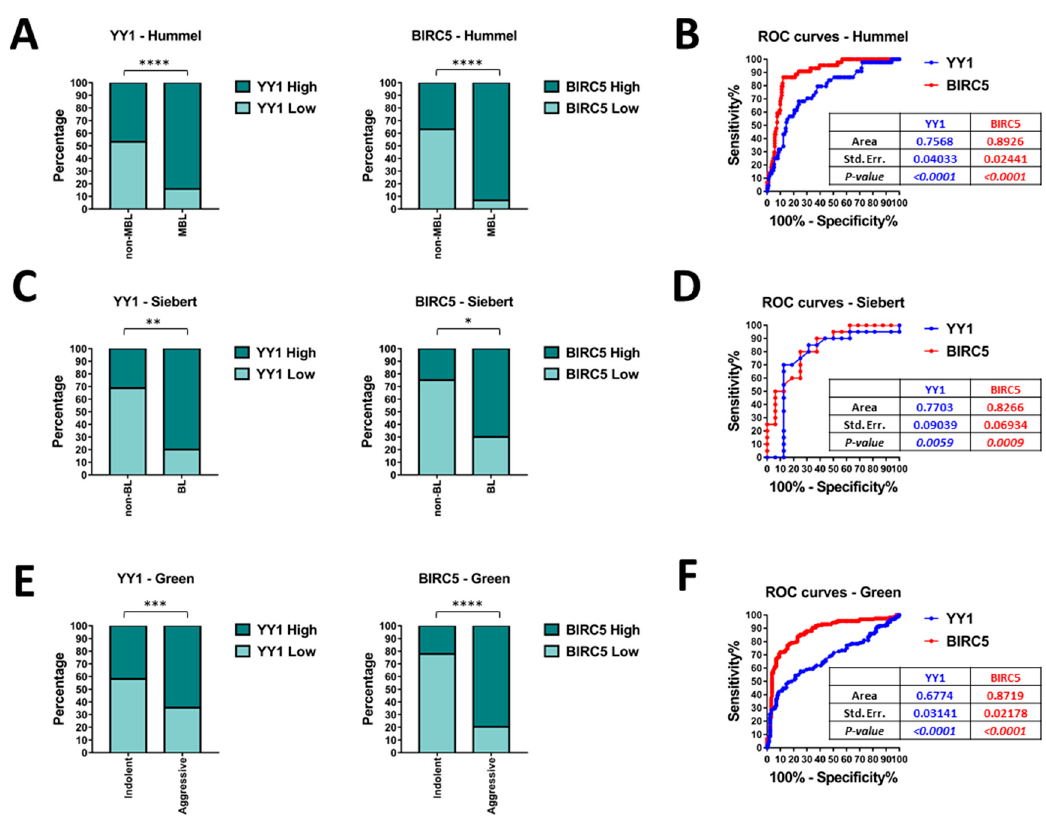
Figure 4. Fisher’s exact test and receiver operating characteristics (ROC) analysis of relevant B-NHL GEO datasets. ( A ). Hummel (GSE4475) GEO dataset Fisher’s exact test for YY1 and BIRC5 in MBL and non-MBL subgroups. ( B ). Hummel (GSE4475) GEO dataset ROC analysis of YY1 (blue) and BIRC5 (red). ( C ). Siebert (GSE10172) GEO dataset Fisher’s exact test for YY1 and BIRC5 in BL and non-BL subgroups. ( D ). Siebert (GSE10172) GEO dataset ROC analysis of YY1 (blue) and BIRC5 (red). ( E ). Green (GSE132929) GEO dataset Fisher’s exact test for YY1 and BIRC5 in aggressive and indolent B-NHL subgroups. ( F ). Green (GSE132929) GEO dataset ROC analysis of YY1 (blue) and BIRC5